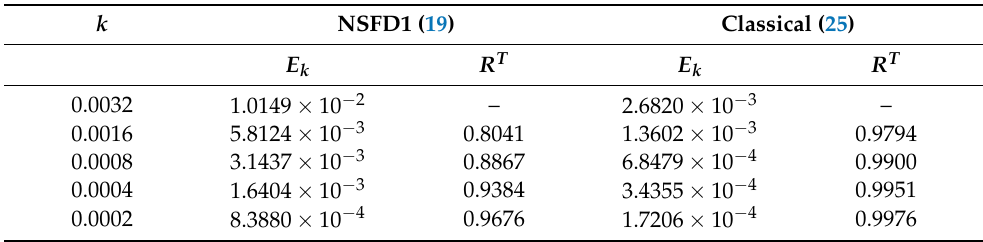
Table 1. Rate of convergence in time using experiment 1 for NSFD1 and classical schemes for h = 0.02 at time t = 8.